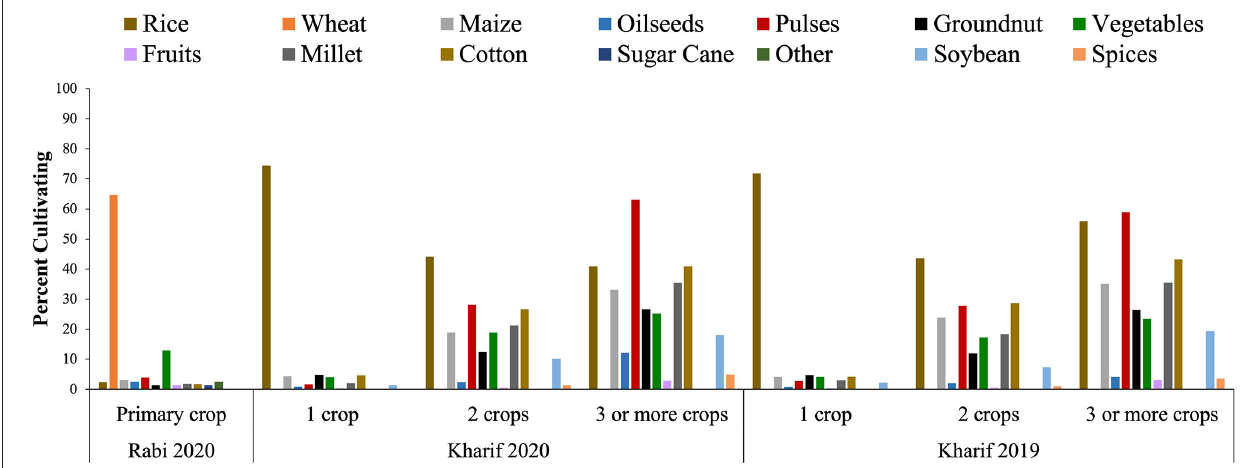
FIGURE 1 | Crops contributing to crop diversity over time in participants from agricultural households across 12 states in India during the COVID-19 pandemic ( n = 775 for Kharif 2020; n = 761 for Kharif 2019; n = 515 for Rabi 2020).